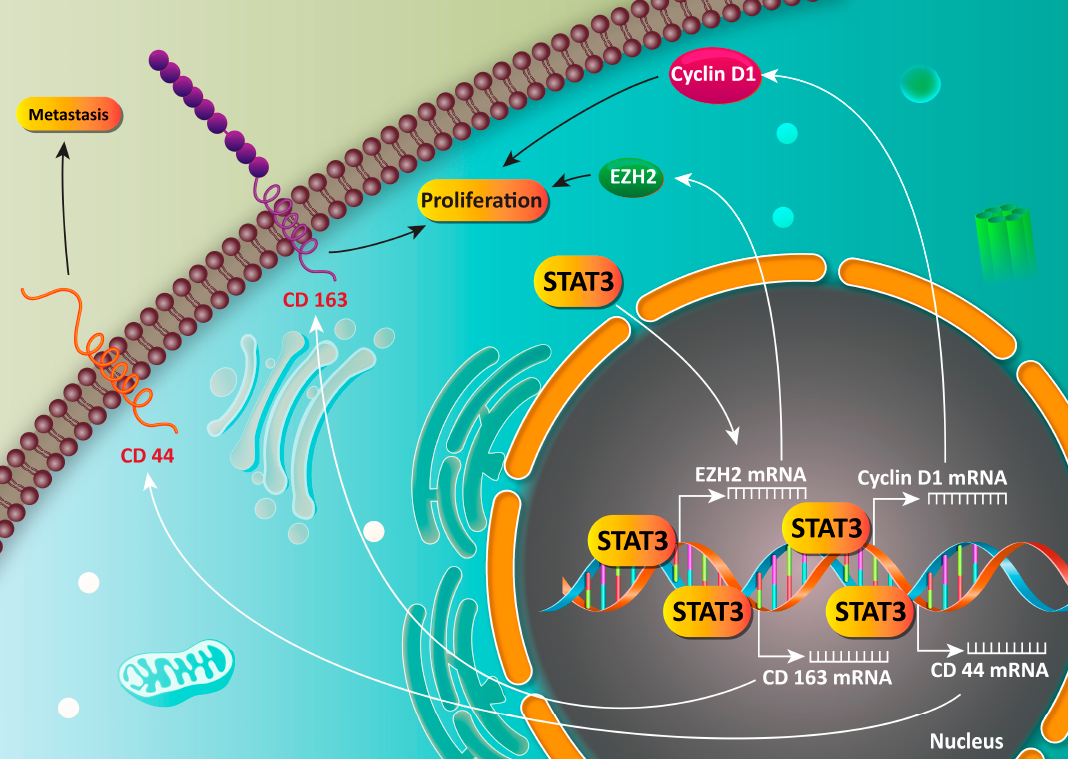
Figure 5. STAT3 signaling pathway as an oncogene factor in GC cells.